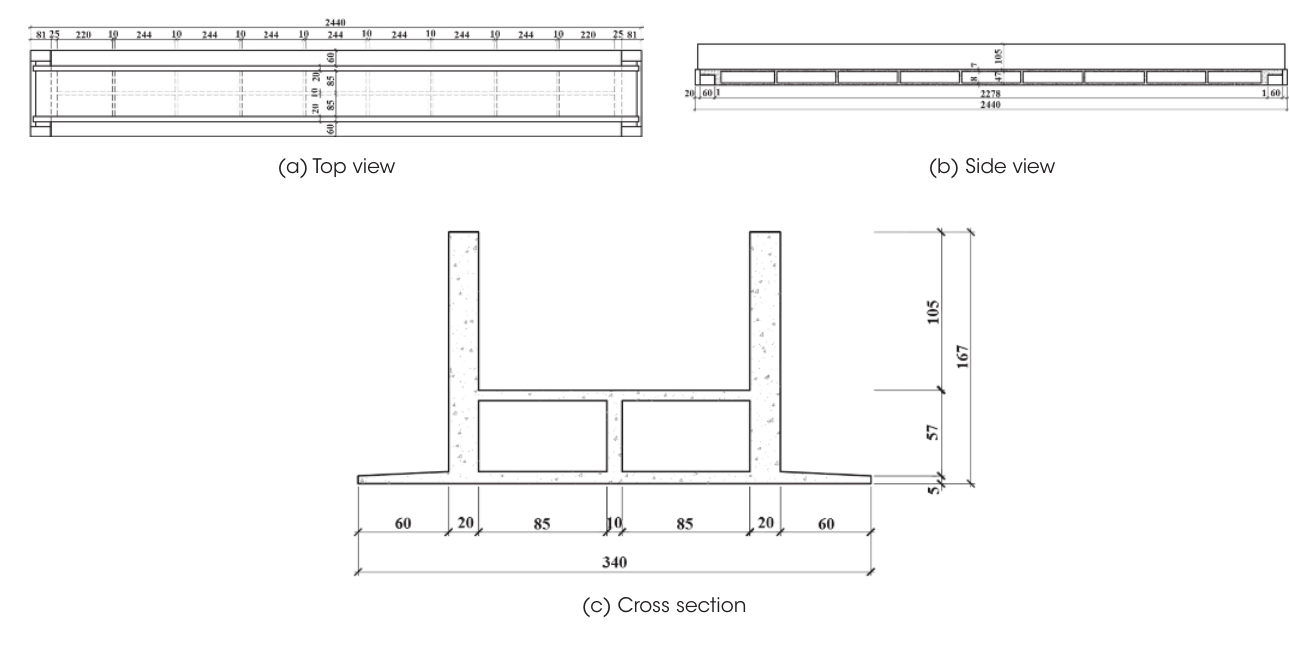
Table 1. Modal analysis tests were carried out in order to obtain the natural frequencies and vibration modes of the structure, the time functions associated with the accelerations in relevant structural sections of the footbridge, the damping coefficients and the experi - mental modal mass values.